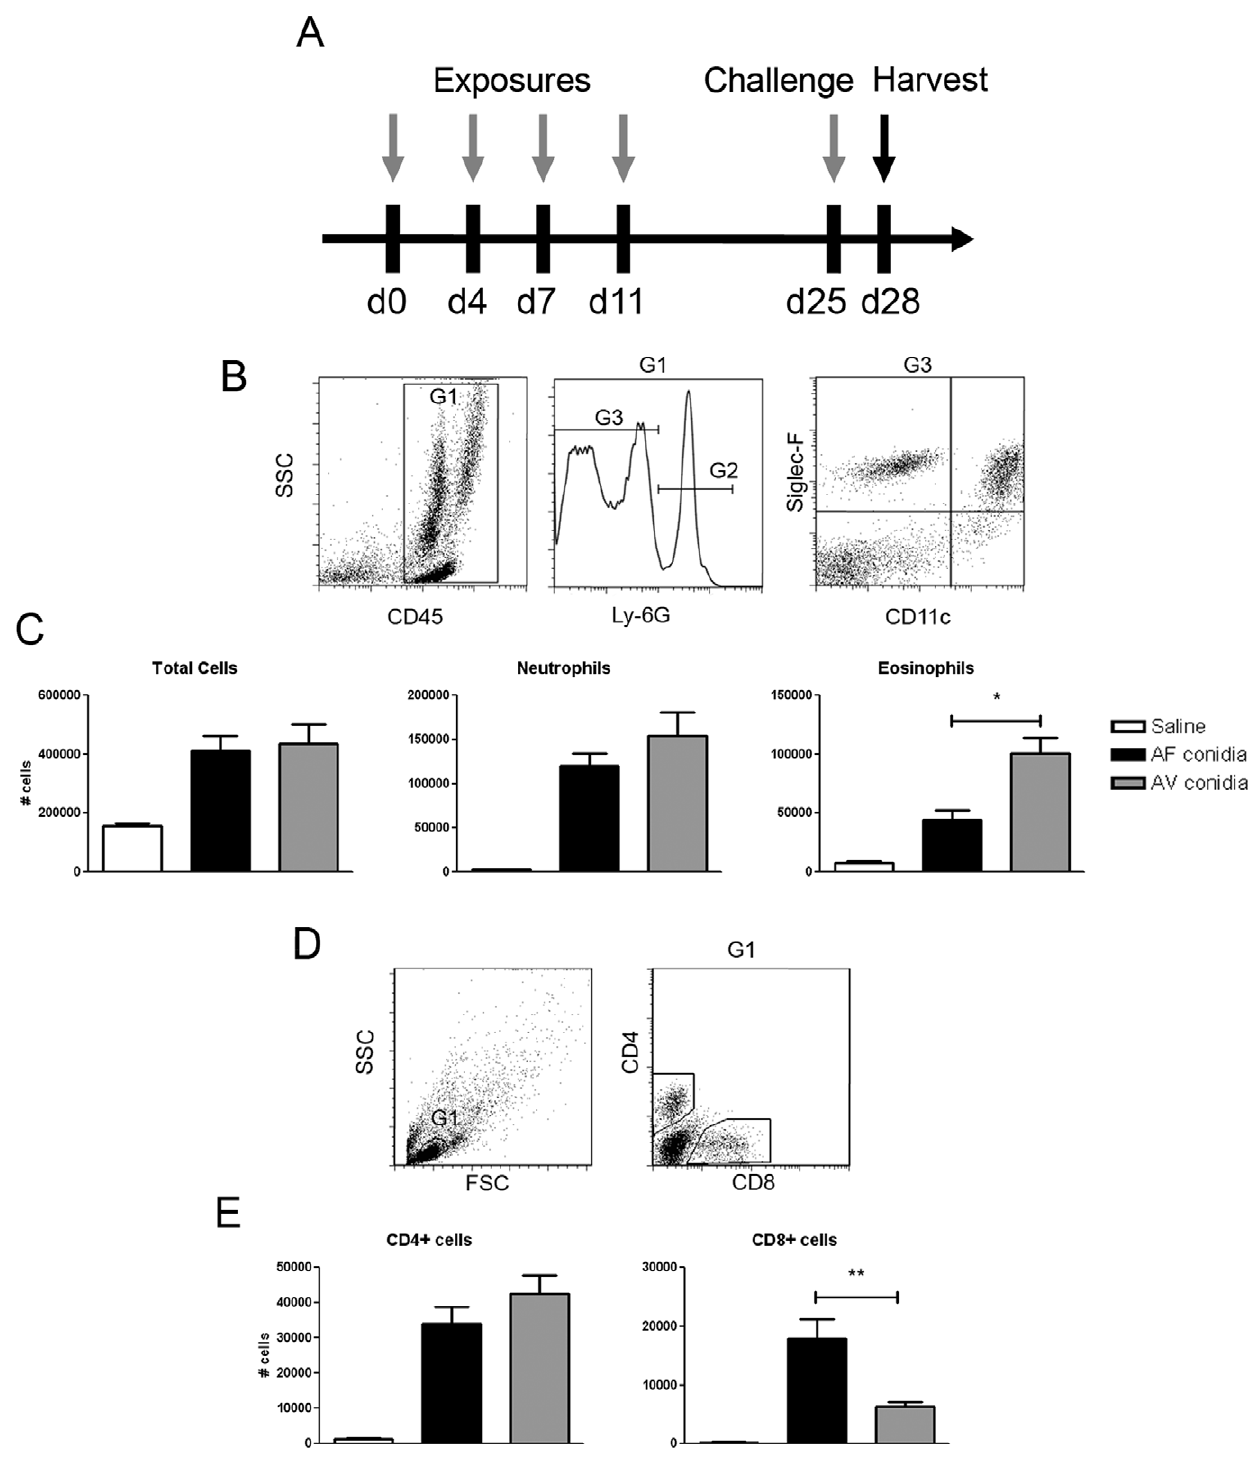
Figure 1. Airway leukocyte recruitment in mice exposed to repeated aspiration of Aspergillus conidia. 1A, BALB/c mice aspirated 2 6 10 6 Aspergillus conidia in suspension at the time points indicated. B, Representative flow cytometric dot plots with granulocyte gating of BALF. Neutrophils were defined as CD45 hi Ly-6G hi CD11c lo (G2). Eosinophils were defined as Ly-6G lo Siglec-F hi CD11c lo in order to distinguish these cells from Ly-6G lo Siglec-F hi CD11c hi alveolar macrophages (G3). C, total # of BALF cells, neutrophils, and eosinophils. D, Representative flow cytometric gating of lymphocytes (left panel), with CD4 + and CD8 + populations (right panel). E, BALF T-cell composition after repeated aspiration of A. fumigatus or A. versicolor conidia. Data depicted in C, E, are a summary of two experiments with 6–11 mice per group. *p , 0.01 , **p , 0.05 .